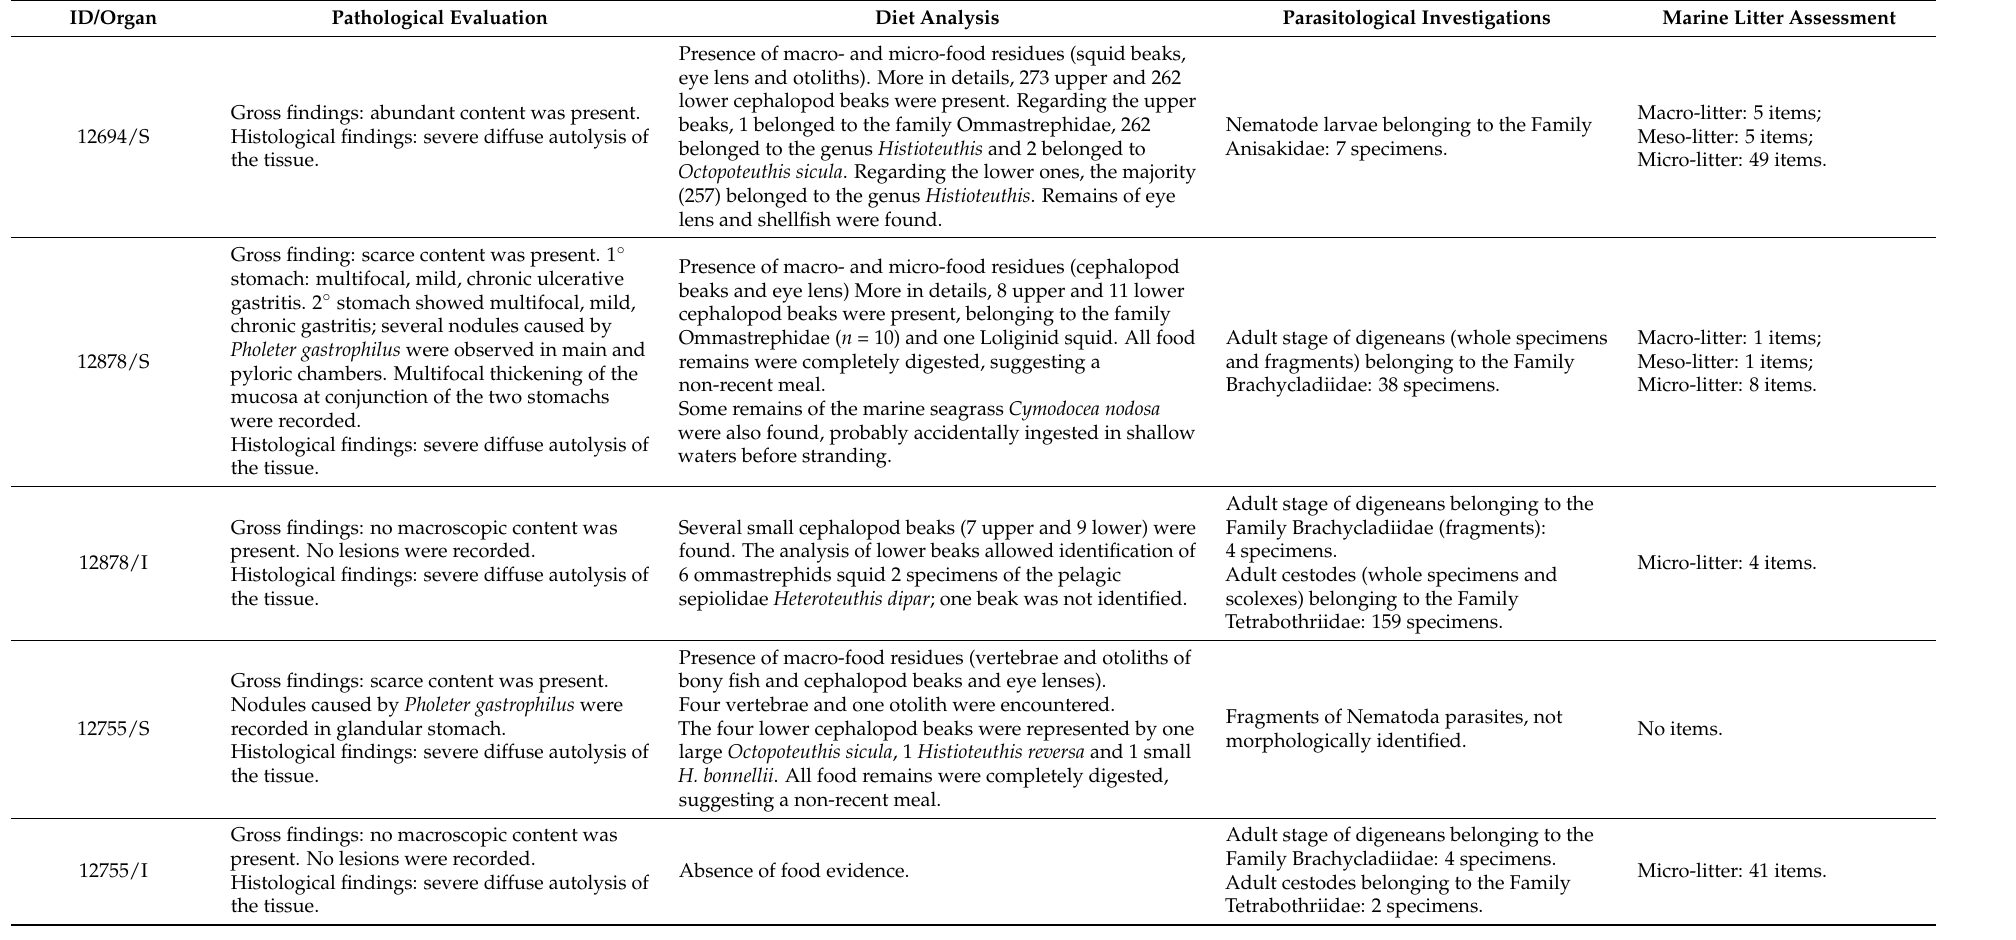
Table 5. General results of the analysis executed on the GITs of cetaceans. S: stomach, I: